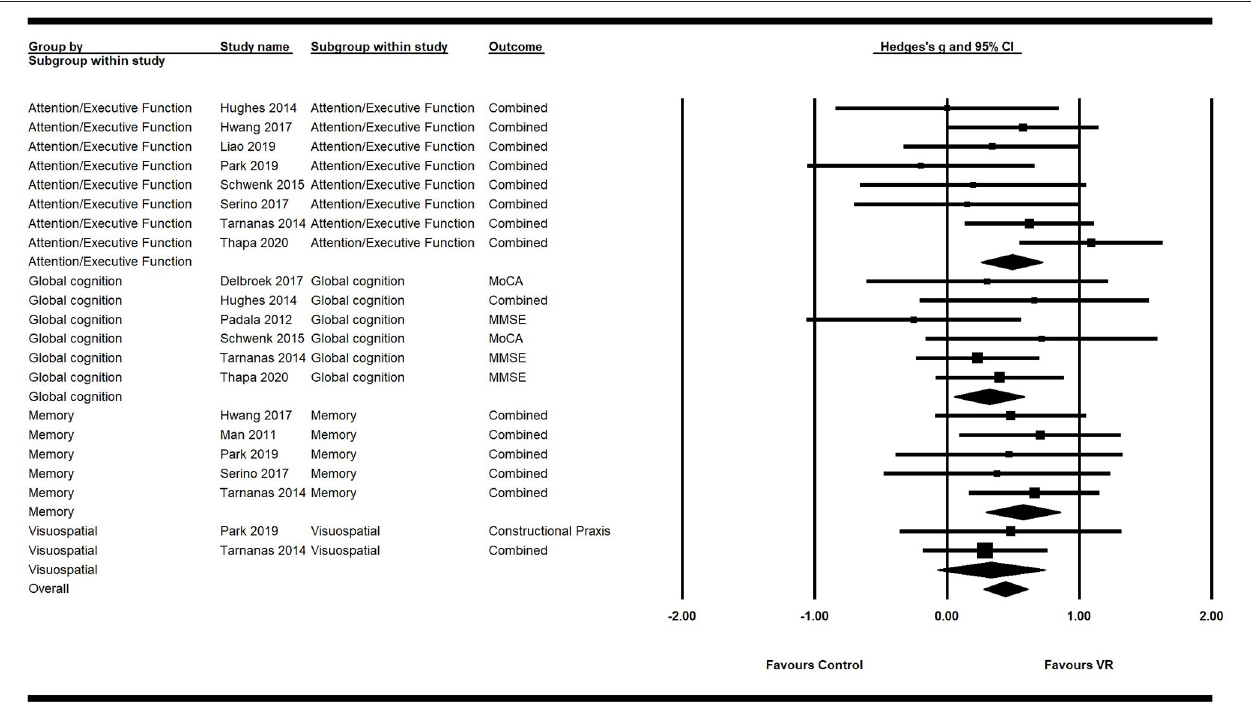
FIGURE 2 | Forest plot for the efficacy of VR intervention on cognitive functions compared with the control group.